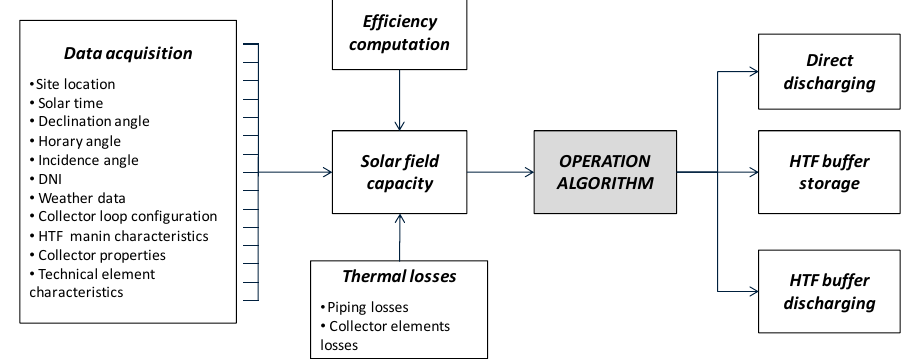
Figure 6. Performance solar field model flow chart for direct discharging and HTF buffering thermal energy storage (TES).